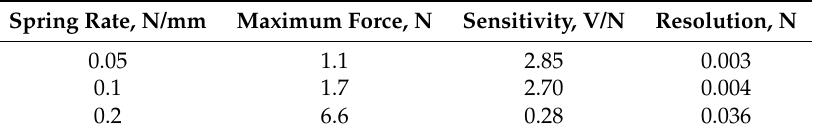
Table 1. Characteristics of tactile elements using different linear